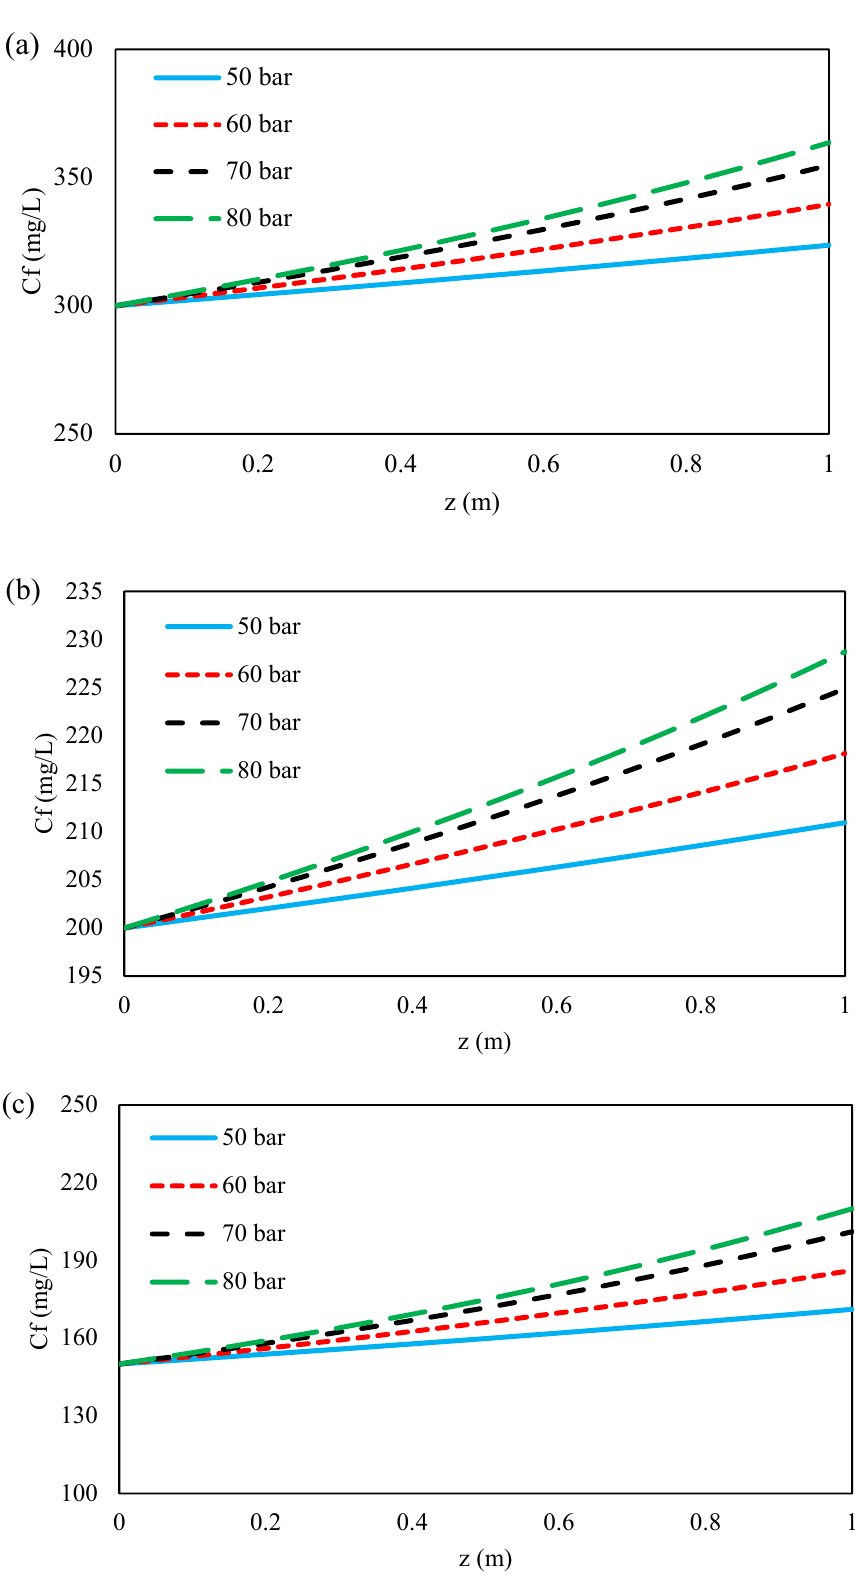
Figure 12. Feed bulk concentration profile during feed side for ( a ) formate, ( b ) acetate, ( c ) sulfate of 45 wt. % MDEA solution at 100 L/h feed flow rate and different inlet feed pressure.